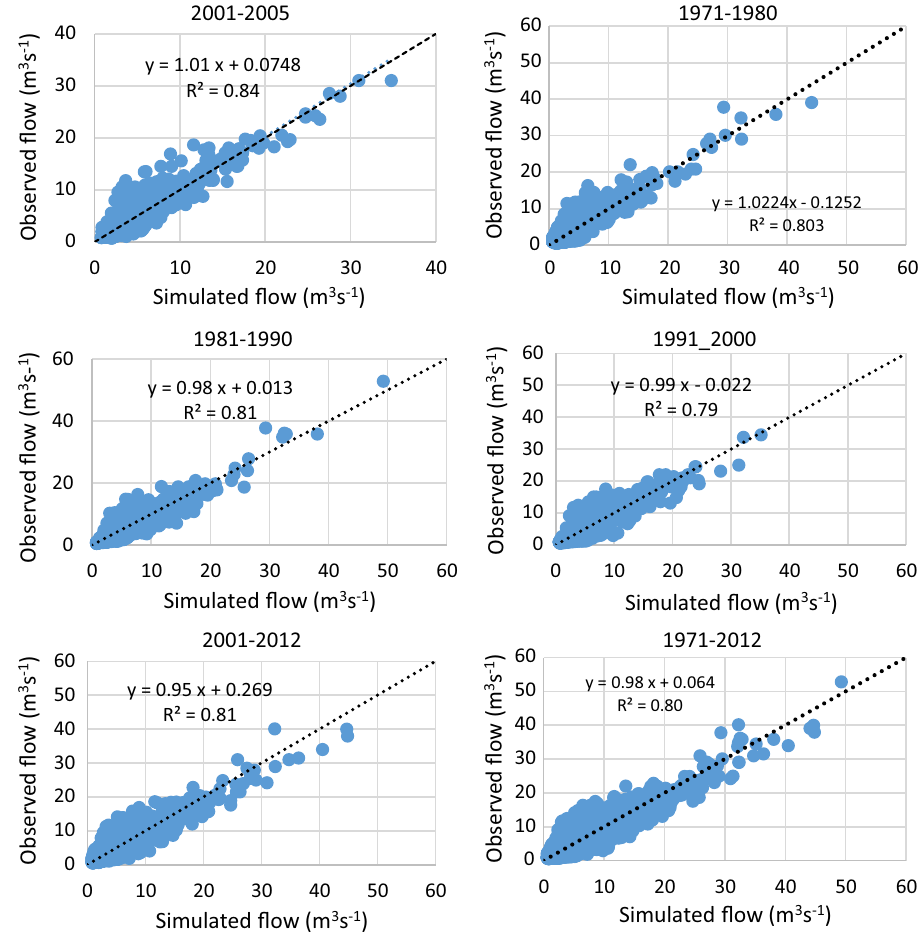
Fig. 8 Relationship between observed and simulated daily flow for the Eden River in Scotland, UK